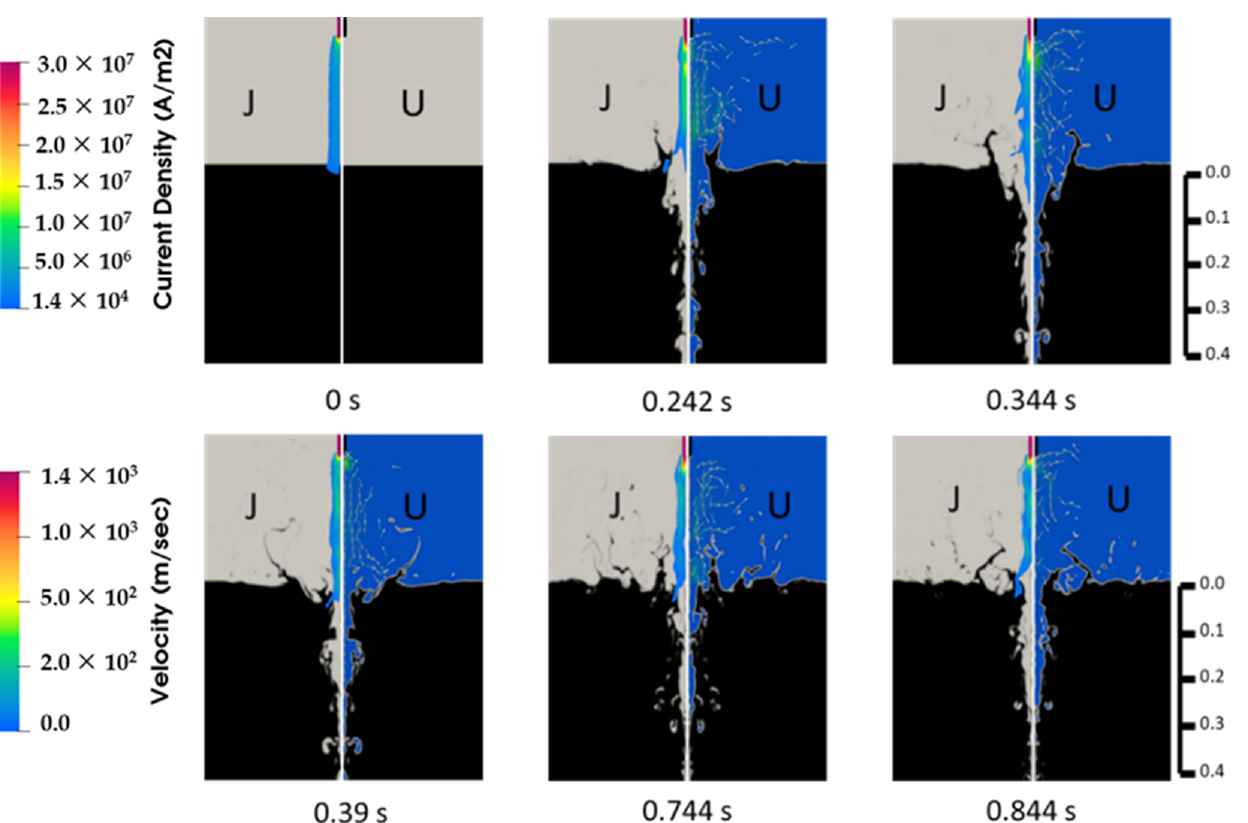
Figure 11. Liquid metal impingement by an arc jet for a gas density of 1 × 10 −2 kg/m 3 .